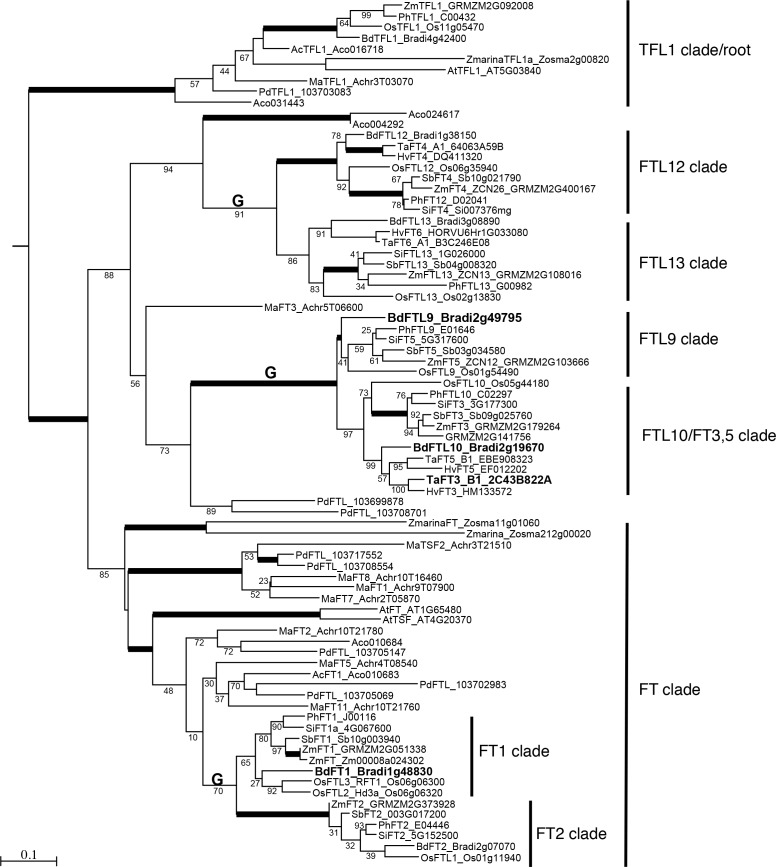
Maximum likelihood phylogenetic relationships among a subset of FT-like genes based on a nucleotide alignment of the PEBP domain.Maximum likelihood bootstrap support values indicated below branches with bold branches indicating bootstrap values of 100. ‘G’ above branch indicates a grass-specific duplication. Scale bar indicates substitutions per site. Focal genes are labeled in large bold font. Note clades FTL9, 10, 12 and 13 contain only monocot species. Abbreviated species names: Bd, Brachypodium distachyon; Os, Oryza sativa; Ta, Triticum aestivum; Hv, Hordeum vulgare; Sb, Sorghum bicolor, Zm, Zea mays; Si, Setaria italica; Ph, Panicum hallii; Pd, Phoenix dactylifera; Ma, Musa acuminata; Z marina, Zostera marina; Ac, Ananas comosus; At, Arabidopsis thaliana. Sequence data were obtained from Phytozome v12 except sequence data for P. dactylifera was obtained from the KEGG database.